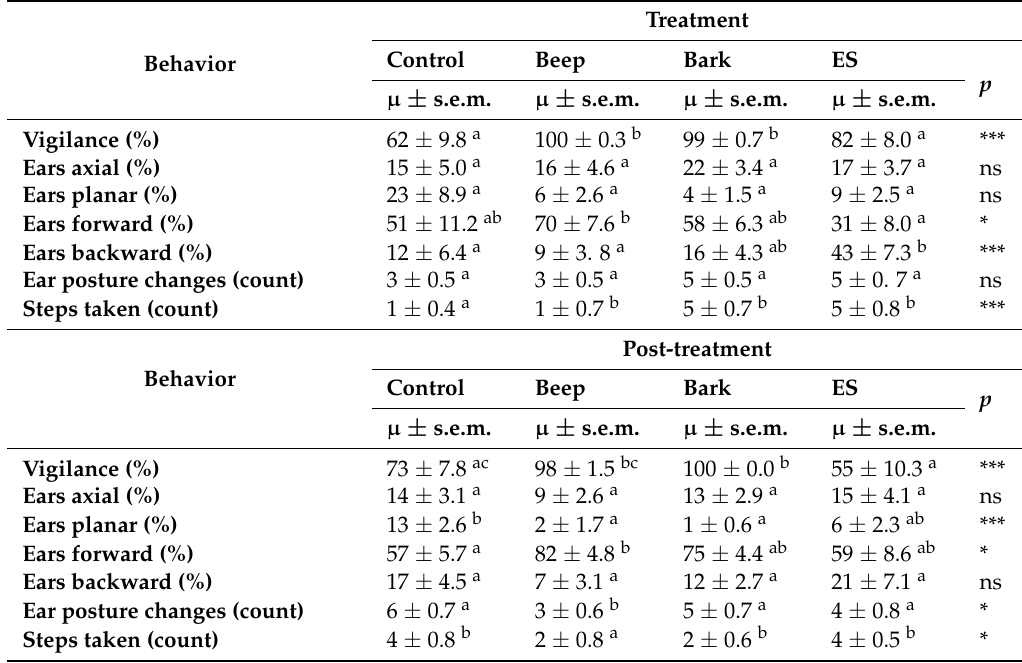
Table 3. Effect of physical (ES) and auditory (beep and bark) stimuli on behaviors during observation period. ES = electrical stimulus